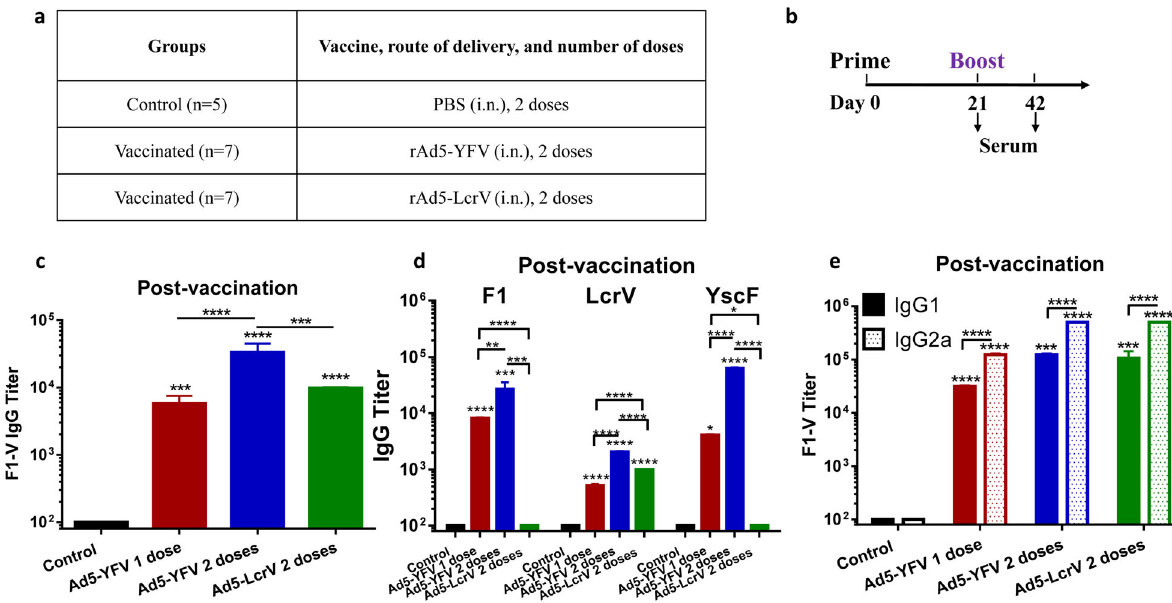
Fig. 3 Antibody responses generated in mice immunized with rAd5-YFV or rAd5-LcrV vaccines. Mice ( n = 5 – 7/group) were immunized (i.n.) twice 21 days apart with 1.2 × 10 10 v.p. of rAd5-YFV or rAd5-LcrV vaccines, with animals that received PBS served as controls ( a , b ). Serum was collected on day 21 after the fi rst dose as well as after the second dose of immunization (day 42) ( b ). The IgG antibody titers to rF1-V fusion protein ( c ) or to each individual antigen rF1, rLcrV, and rYscF ( d ), as well as the IgG1 and IgG2a isotype titers to rF1-V fusion protein ( e ), were measured by ELISA. The geometric mean of each sample ± standard deviations was used for data plotting. P values were calculated using a one-way or two-way ANOVA with Tukey ’ s post-hoc test to compare multiple groups or Student ’ s t -test to compare two groups. Asterisks above columns represent comparison to the control group, while horizontal bars represent differences between test groups. * P < 0.05, ** P < 0.01, *** P < 0.001, **** P < 0.0001. Two biological replicates were performed, and data